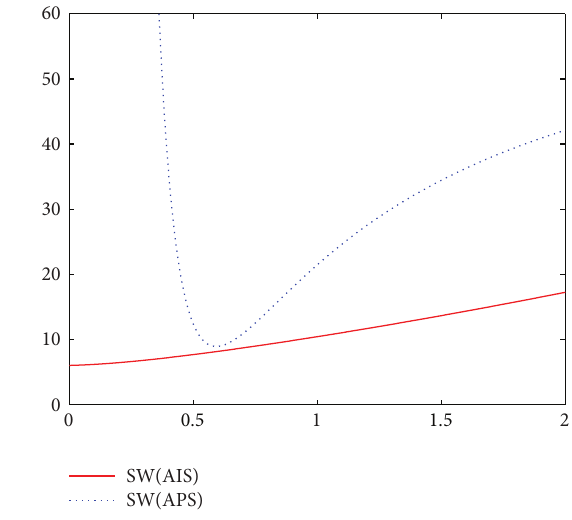
Figure 3: Equilibrium production.